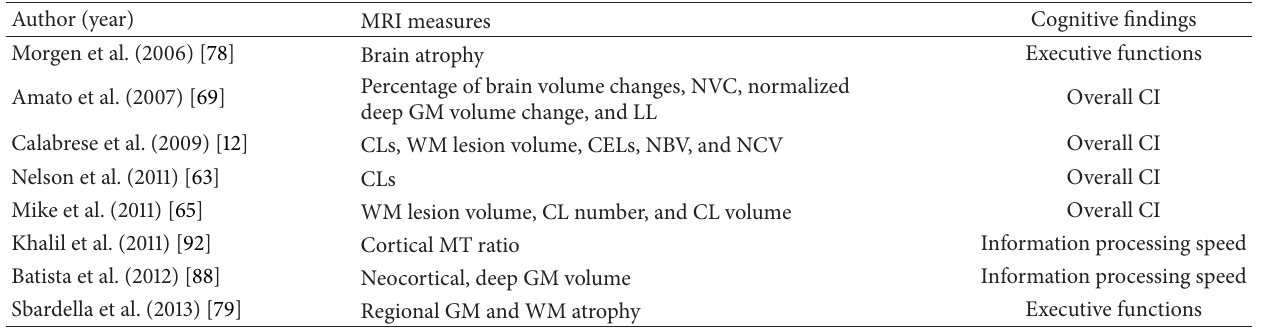
Table 1: Studies investigating the role of MRI measures and cognition in